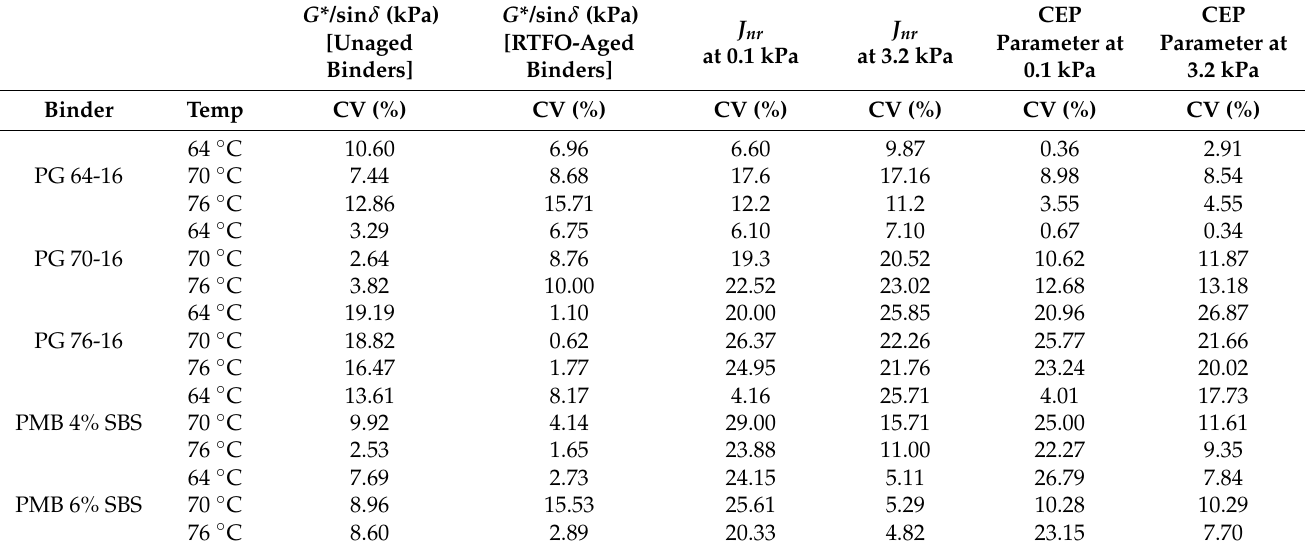
Table 5. Coefficient of variations (% CV) of different binder rheological